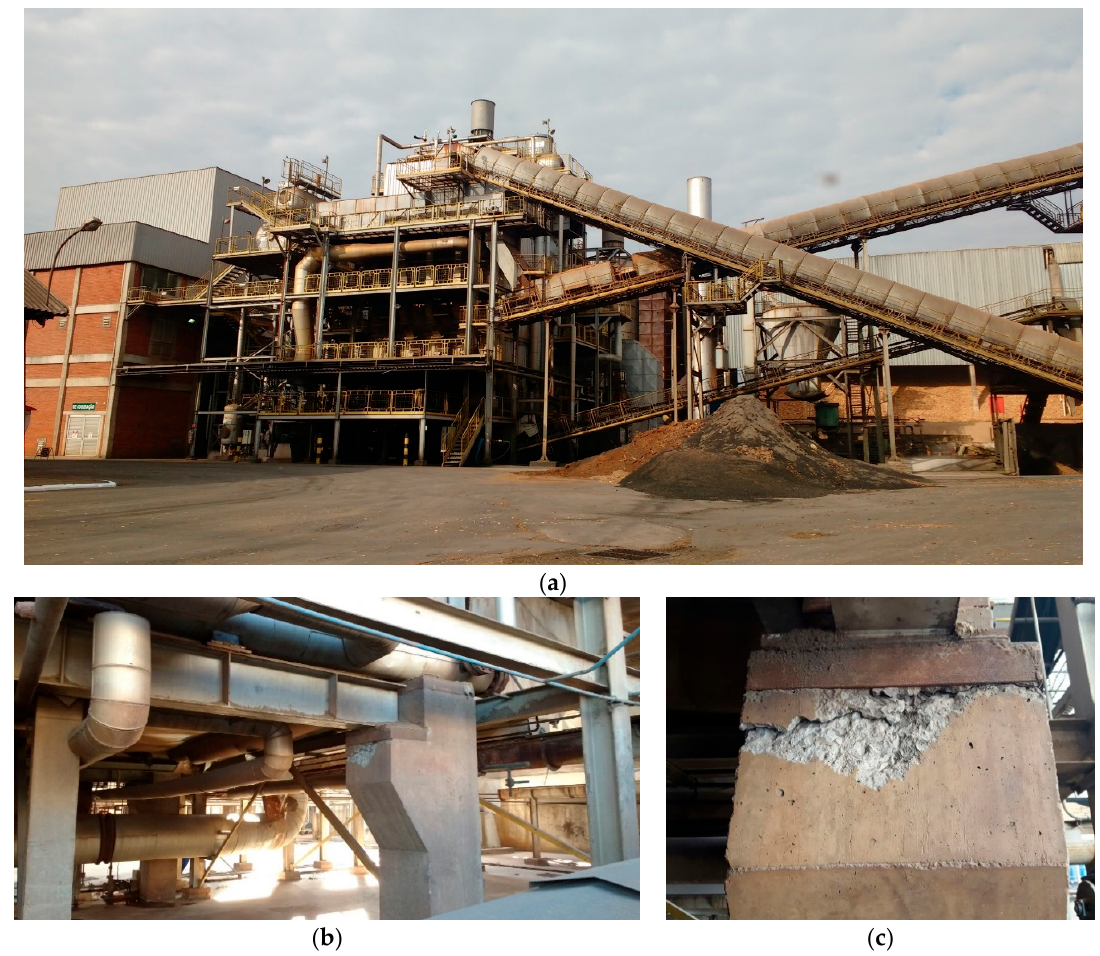
Figure 5. ( a ) Biomass industrial boiler; ( b ) reinforced concrete corbel supporting a W ‐ beam; and ( c ) detail of the spalled concrete at the face of the corbel due to inadequate position of the load bearing plate.